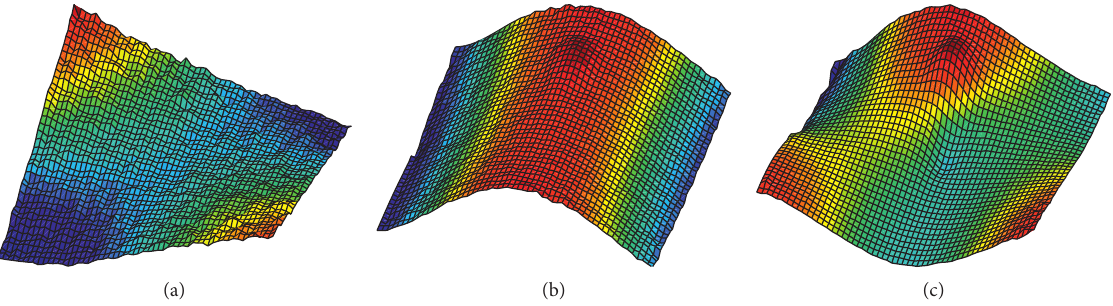
Figure 7: Example of the first three experimental mode shapes. (a) 488Hz. (b) 612 Hz. (c) 968Hz.